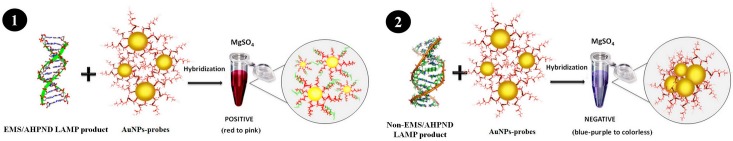
Schematic illustration of the detection of VPAHPND using DNA-functionalized gold nanoparticles as colorimetric hybridization probes to detect complementary LAMP amplicons.(1) Positive reaction for VPAHPND. (2) Negative reaction for VPAHPND.